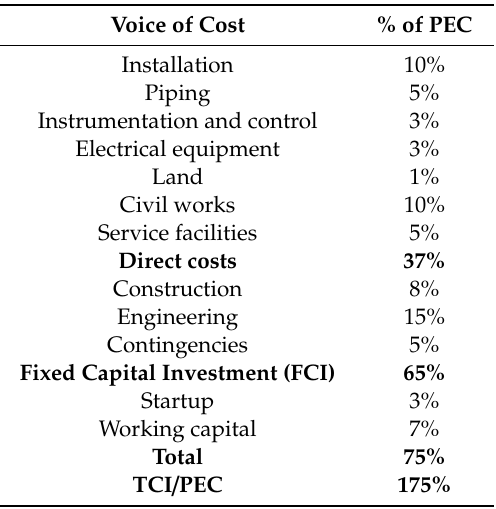
Table 3. Main voices for economic analysis in W-ECoMP